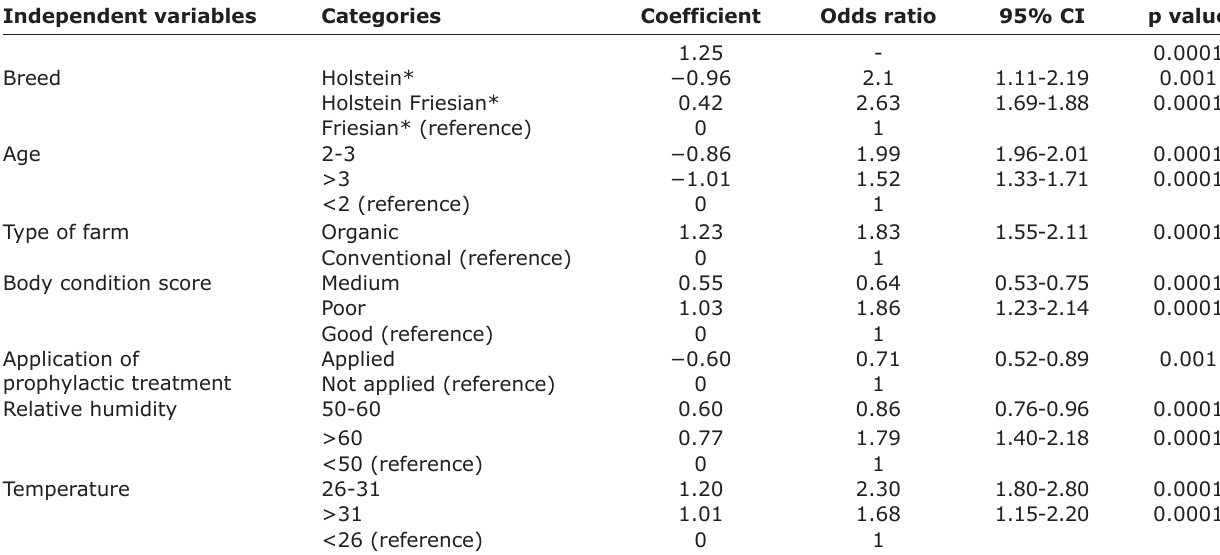
Table-3: Multiple logistic regression (final model) analysis of the risk factors associated with the prevalence of bovine fascioliasis in the Nile Delta region of Egypt. Independent variables